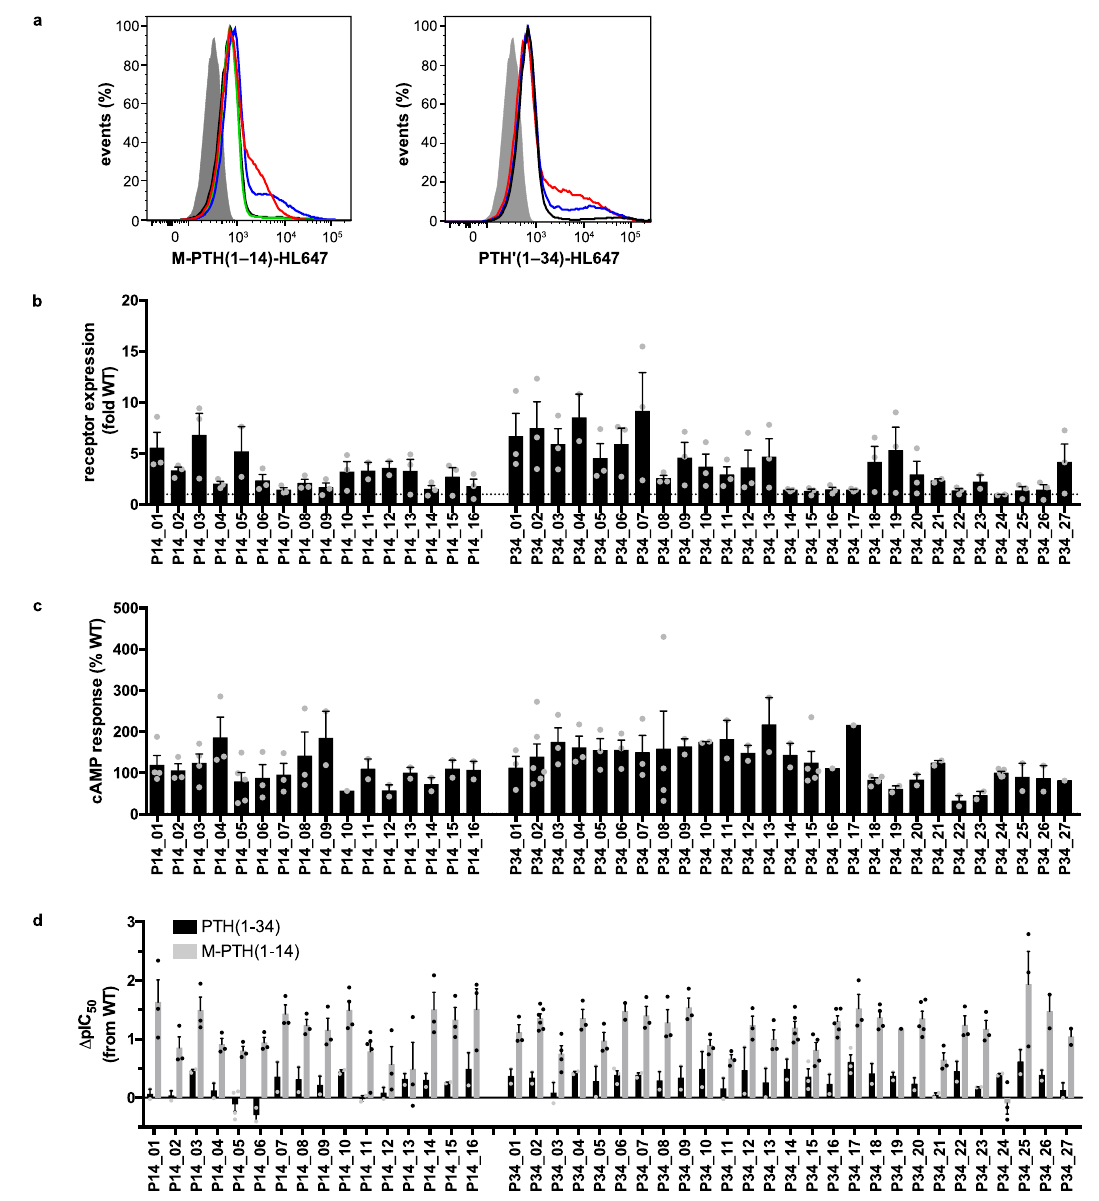
Fig. 3 | EvolutionofPTH1R inmammalian cellsyieldssignaling-activereceptor variants with increased ligand af fi nity. a Comparison of the populations after selectionwithPTH ’ (1 – 34)-HL647(leftpanel)orM-PTH(1 – 14)-HL647(rightpanel)to wild-type PTH1R: sort 1 (red line), sort 2 (blue line), sort 3a (black line), sort 3b (green line, repetition of 3a), negative control (dark gray shaded). b Expression analysis of 43 evolved PTH1R variants assessed in live HEK293T cells by fl ow cytometryanalysiswithsaturatingconcentrationsofPTH ’ (1 – 34)-HL647.Expression levels are relative to wild-type receptor expression and are given as mean values±s.e.m. of 2 – 3 independent experiments (Supplementary Table 3). c cAMP accumulation of 43 evolved PTH1R variants after stimulation with 1 µ M PTH(1 – 34).